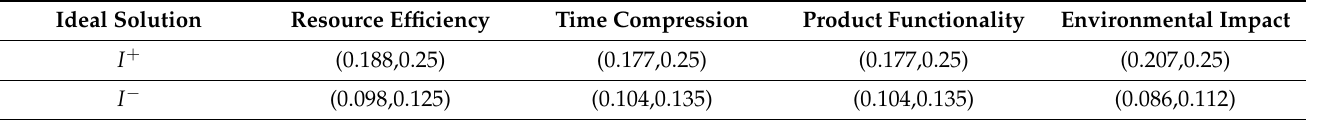
Table 8. Positive and negative ideal solutions.